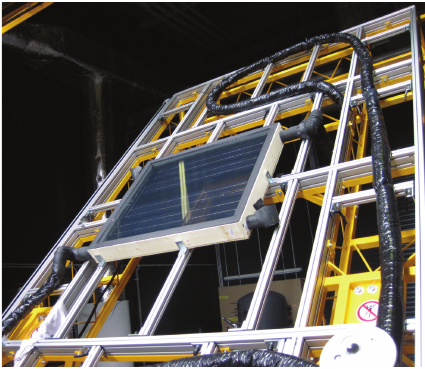
Figure 2: Glazed nonselective PVT collector at indoor test